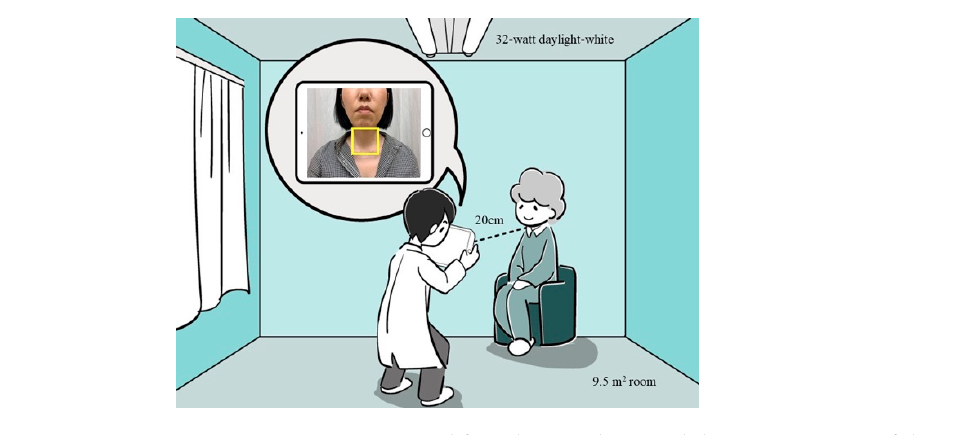
Figure 1. Environment used for taking a photo and the cropping area of the image. The cropping area is indicated by yellow square.